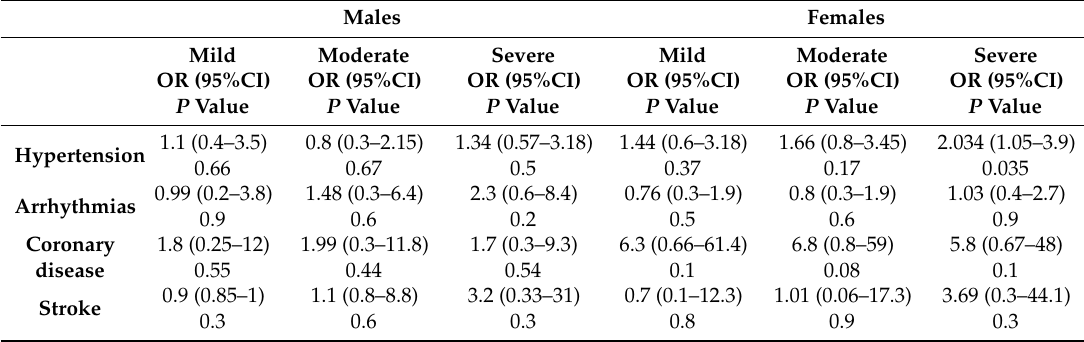
Table 3. Multiple regression analysis, after adjusting for age, BMI, and smoking, for the association of cardiovascular co-morbidities with gender and the severity of obstructive sleep apnea (OSA). Males Females Severe Moderate Mild Severe Moderate Mild OR (95%CI) OR (95%CI) OR (95%CI) OR (95%CI) OR (95%CI) OR (95%CI) P P Value P Value P Value P Value P Value